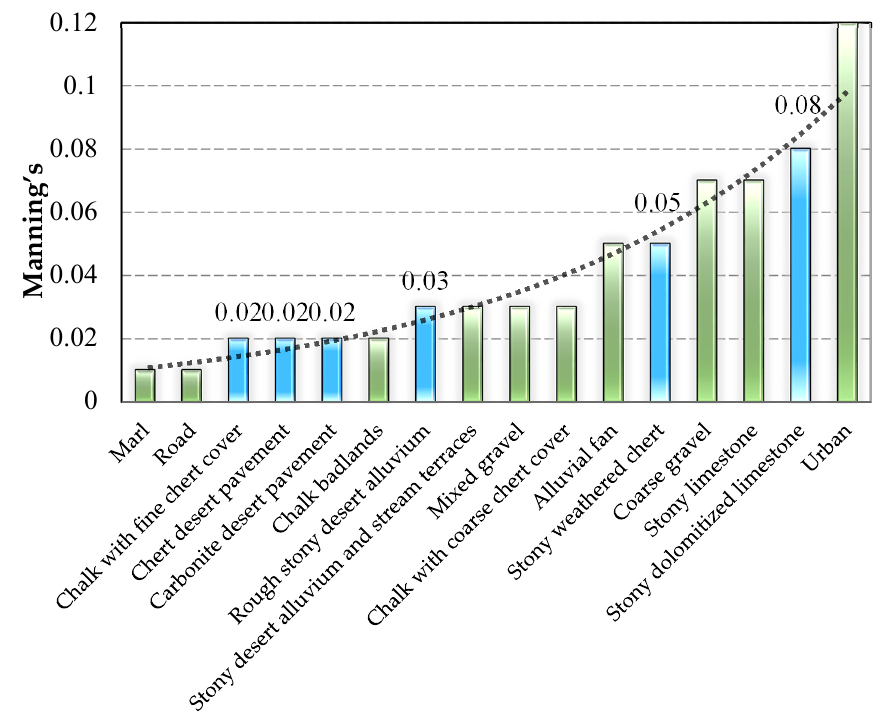
Figure 7. Manning’s n values of the 16 geomorphological units in the study area ordered according to their roughness level. The six geomorphological units that were analyzed using the SAR data are colored in blue.